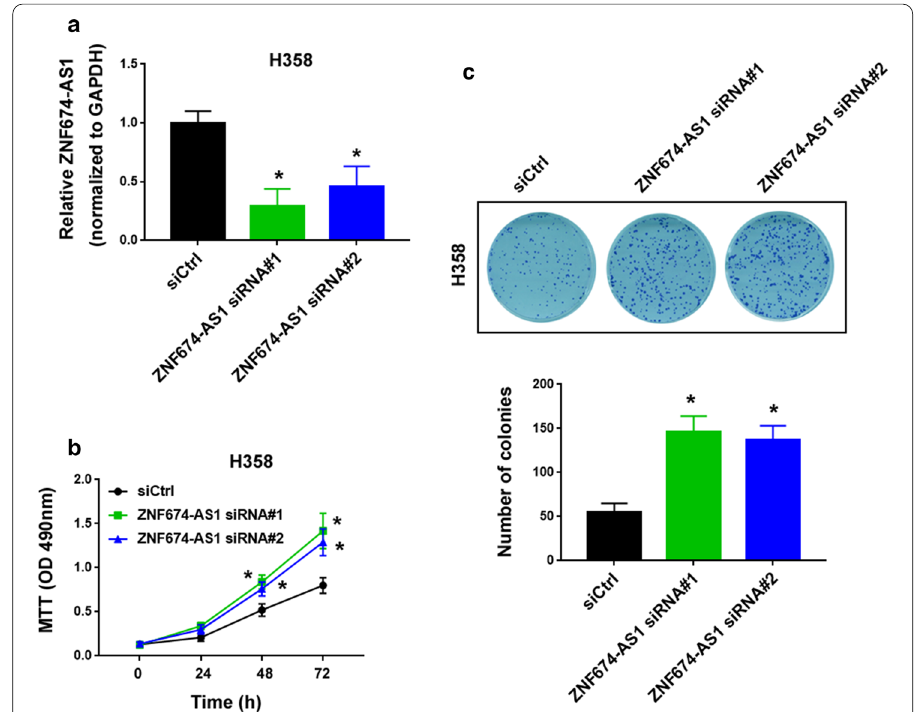
Fig. 4 Knockdown of ZNF674-AS1 accelerates NSCLC cell growth and colony formation. a The level of ZNF674-AS1 transcript was analyzed in H358 cells transfected with control siRNA (siCtrl) or ZNF674-AS1-targeting siRNAs. b MTT assay showed the induction of proliferation in ZNF674-AS1-depleted H358 cells. c Assessment of colony formation in H358 cells transfected with indicated siRNAs. * P < 0.05 vs.